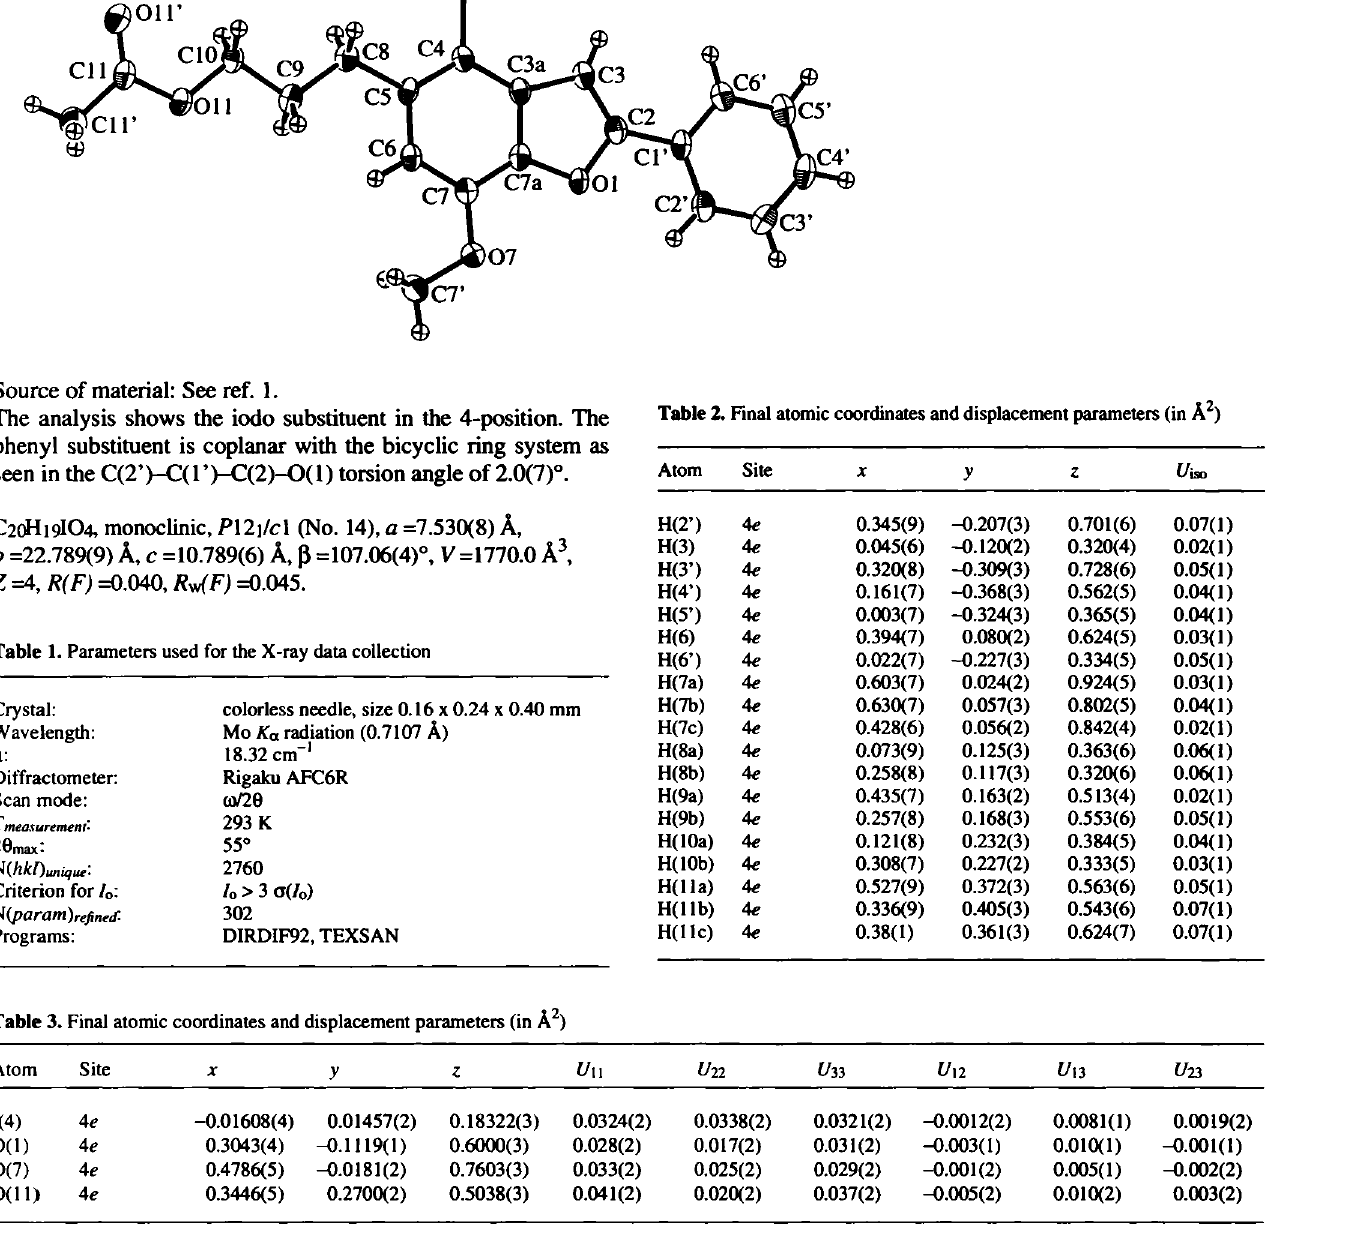
Table 2. Hnal atomic coordinates and displacement parameters (in A^)